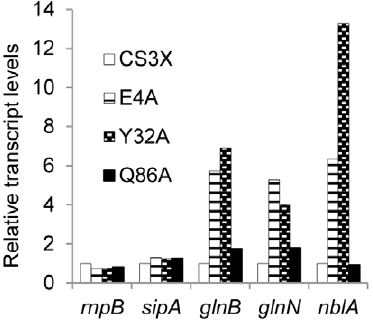
Figure 5. Real-time RT-PCR for rnpB , sipA , glnB , glnN and nblA genes. Cultures of CS3X and derivatives (for which relevant mutations are indicated) were grown in the presence of nitrate. Transcription levels were calculated relative to the control strain amount (set at 1). Representative data from two independent experiments carried out by duplicate are shown.